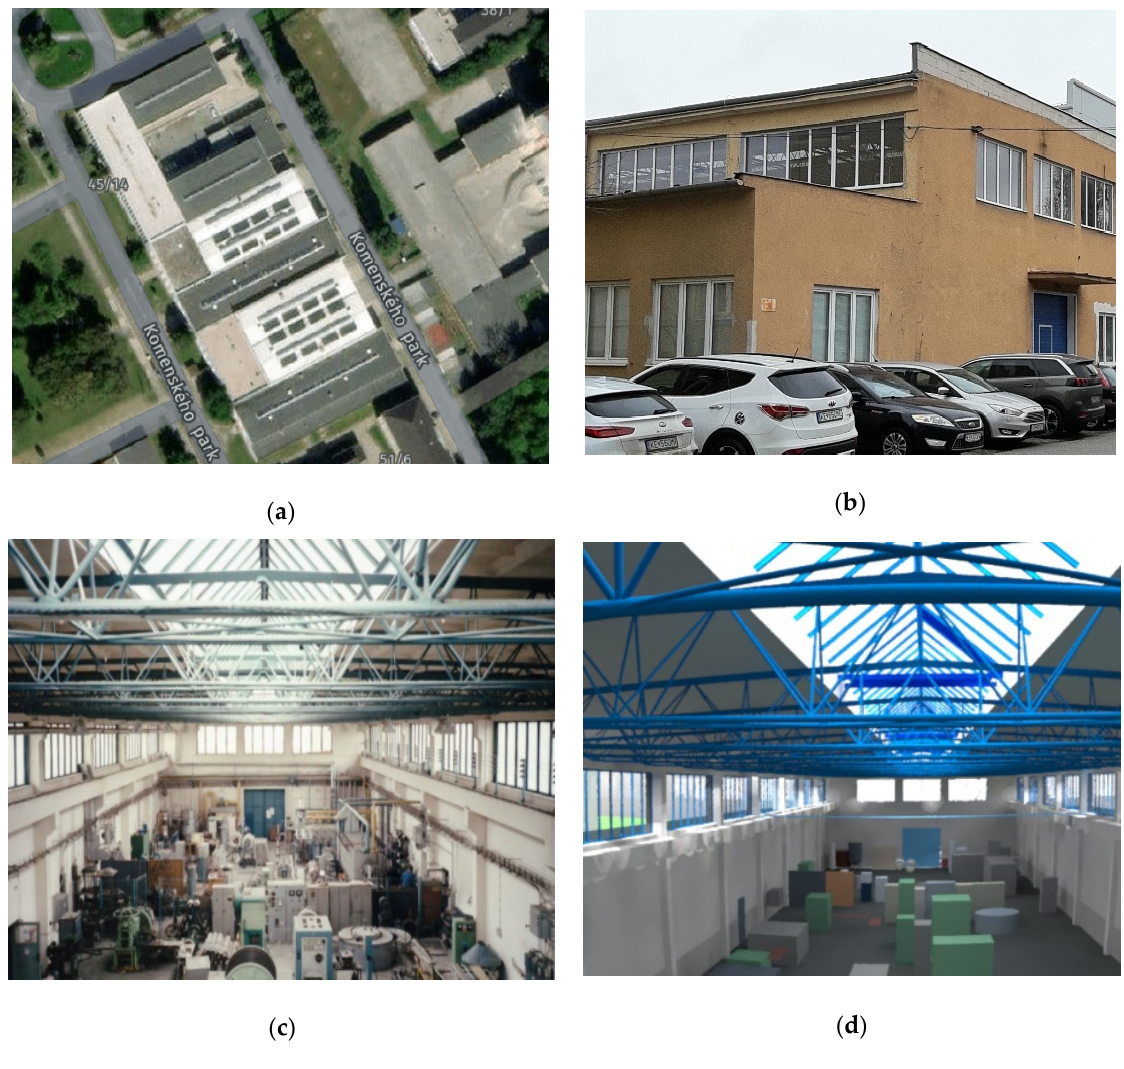
Figure 4. The reference hall selected for daylight simulations; Source for situation maps: https://www.google.sk/maps/search/Ko%C5%A1ice,+Park+Komensk%C3%A9ho/@48.7325581,21.246384,581m/data=!3m2!1e3!4b1 (accessed on 6 April 2022). ( a ) situation map. ( b ) external view of hall. ( c ) internal view of hall building. ( d ) render of the selected hall by RADIANCE .